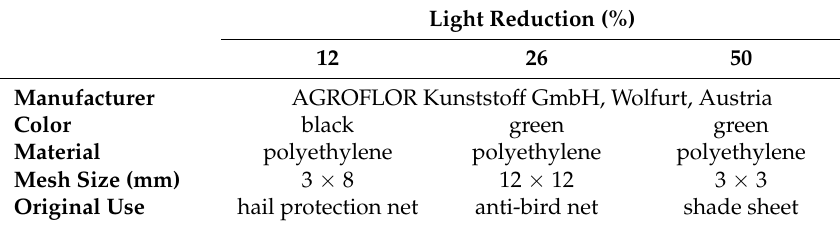
Table 2. Characteristics of the nets used for light